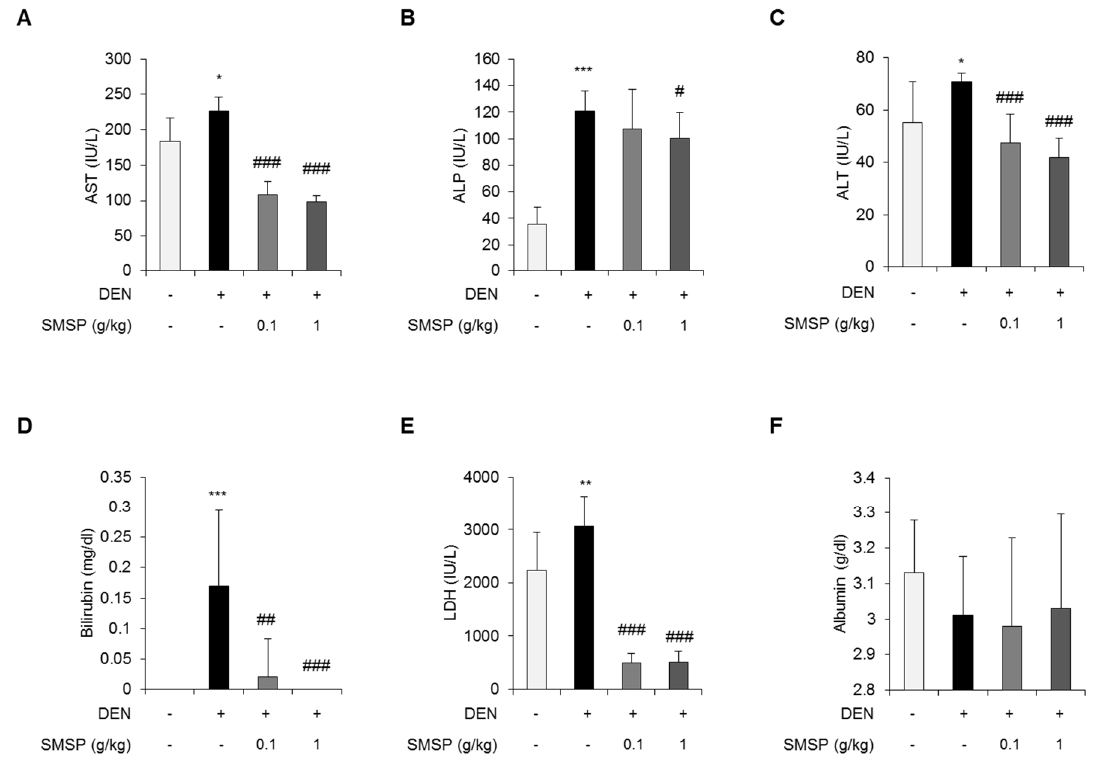
Figure 2. SMSP attenuates liver injury in rats treated with DEN for 16 weeks. Serum levels of ( A ) aspartate aminotransferase (AST), ( B ) Serum alkaline phosphatase (ALP), ( C ) alanine aminotransferase (ALT), ( D ) bilirubin, ( E ) lactate dehydrogenase (LDH), and ( F ) Albumin. Data are the mean ± SD ( n = 10). Statistical significance was analyzed by ANOVA. * p < 0.05, ** p < 0.01, and *** p < 0.001 compared to control; # p < 0.05, ## p < 0.01, and ### p < 0.001 compared to the DEN